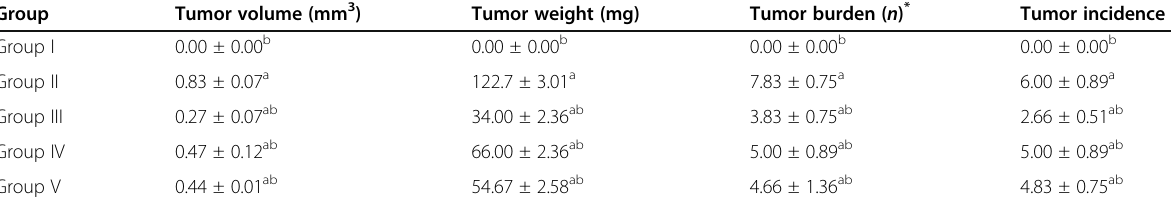
Table 2 Effect of ethanolic extract of T. chebula on tumor parameters Group